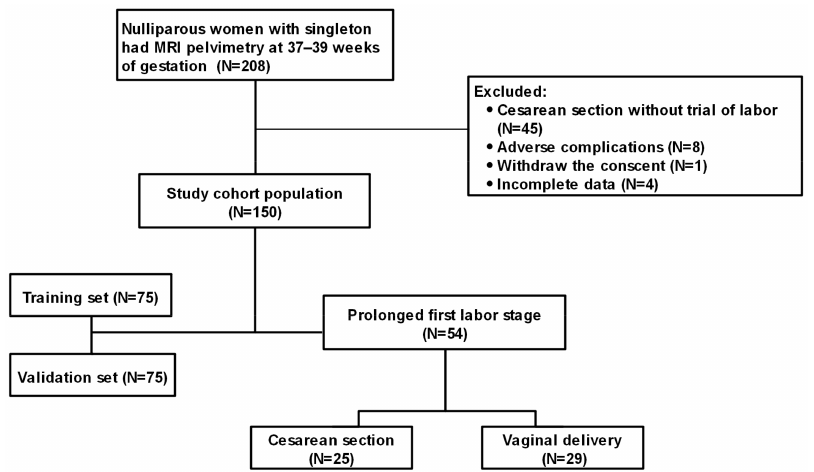
Figure 1. The study participant flow diagram. Nulliparous women with singleton gestation had MRI pelvimetry (excluding those with comorbidities who underwent cesarean section without trial of labour) at 37 to 39 weeks of gestation. A study cohort of 150 pregnant women was first divided into the training and validation sets, then those with a prolonged first stage of labour were classified into the cesarean section and vaginal delivery